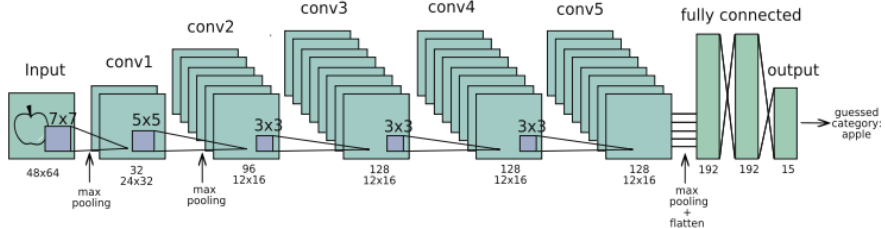
Figure 11. Architecture of AlexNet [133].